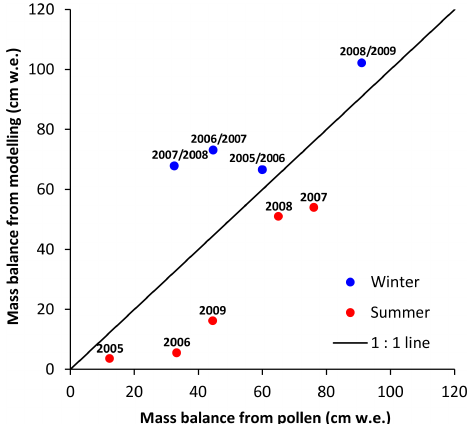
Figure 5. Comparison of the winter and summer mass balance as obtained by pollen dating and modeling